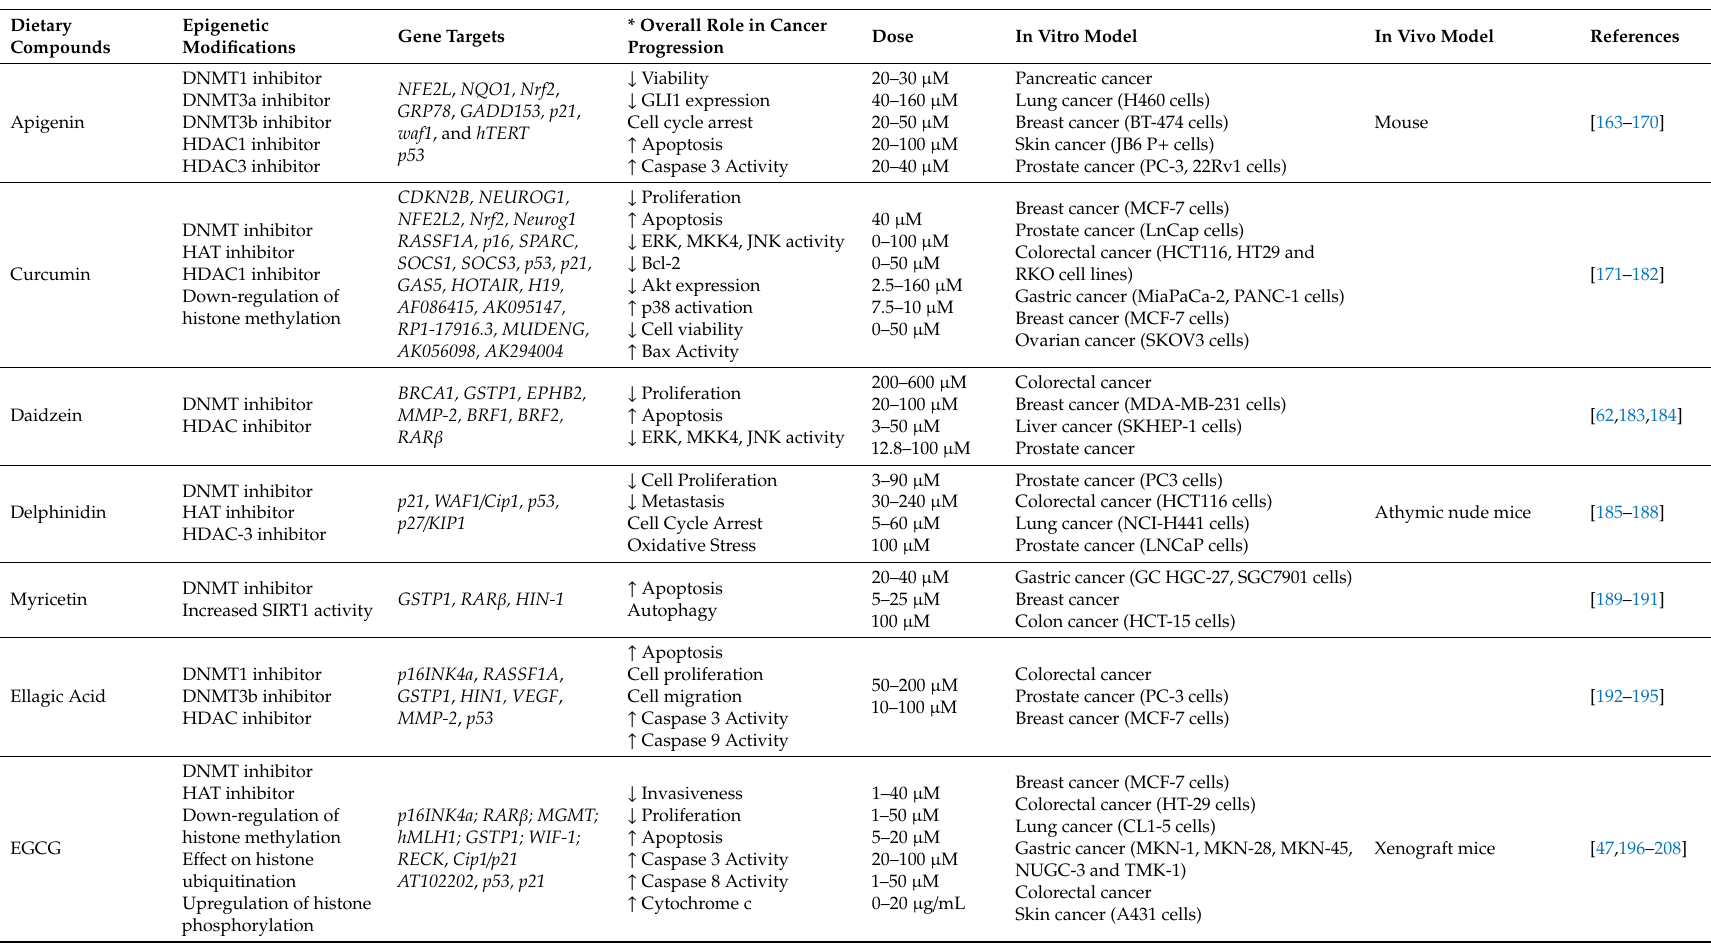
Table 2. Assessment of polyphenols and their associated epigenetics modifications and molecular mechanisms (in vivo and in vitro studies) in cancer. Dietary